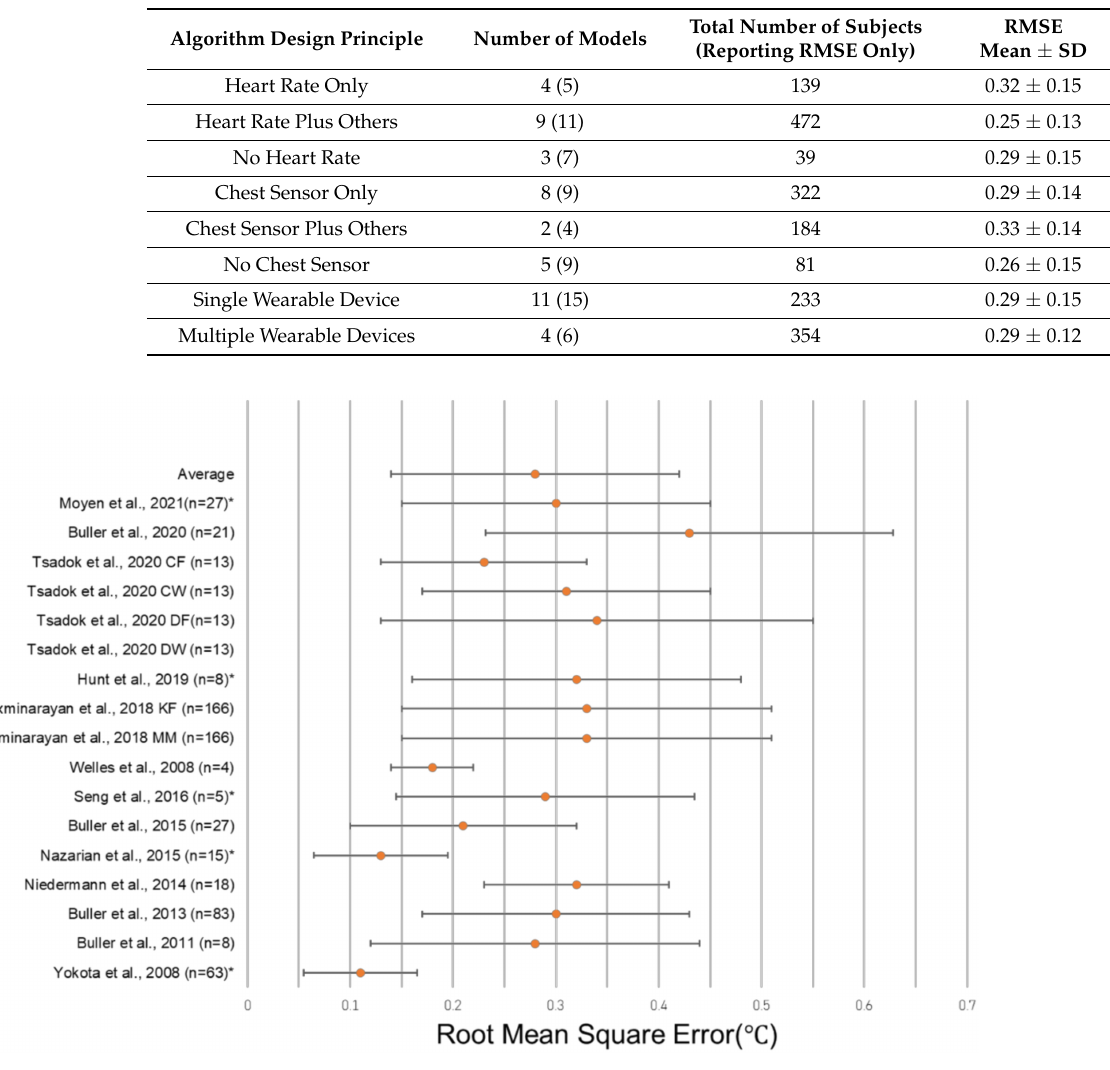
Table 3. Comparison of the overarching design principles. One study did not report the sensor location. Model numbers prior to the parentheses indicate the number of models reporting the RMSE and found in Table 4 only, while the model numbers in parentheses include models listed in Tables 4 and 5 reporting the RMSE, MD, and SEE. Values in italics indicate the outlier Tsadok et al. DW [47] was excluded from that data set.